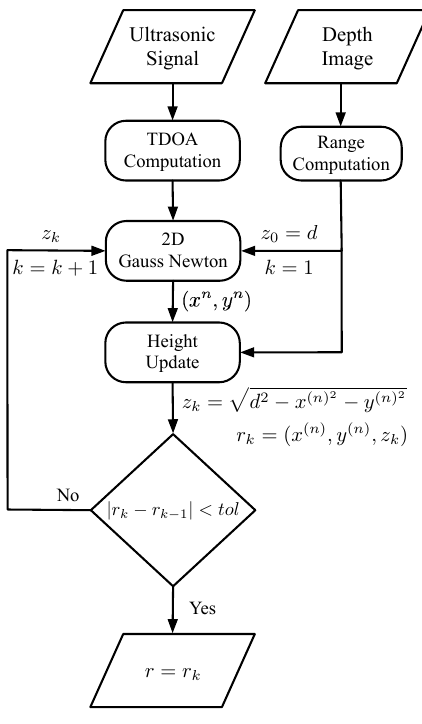
Figure 8. Flux diagram of the positioning